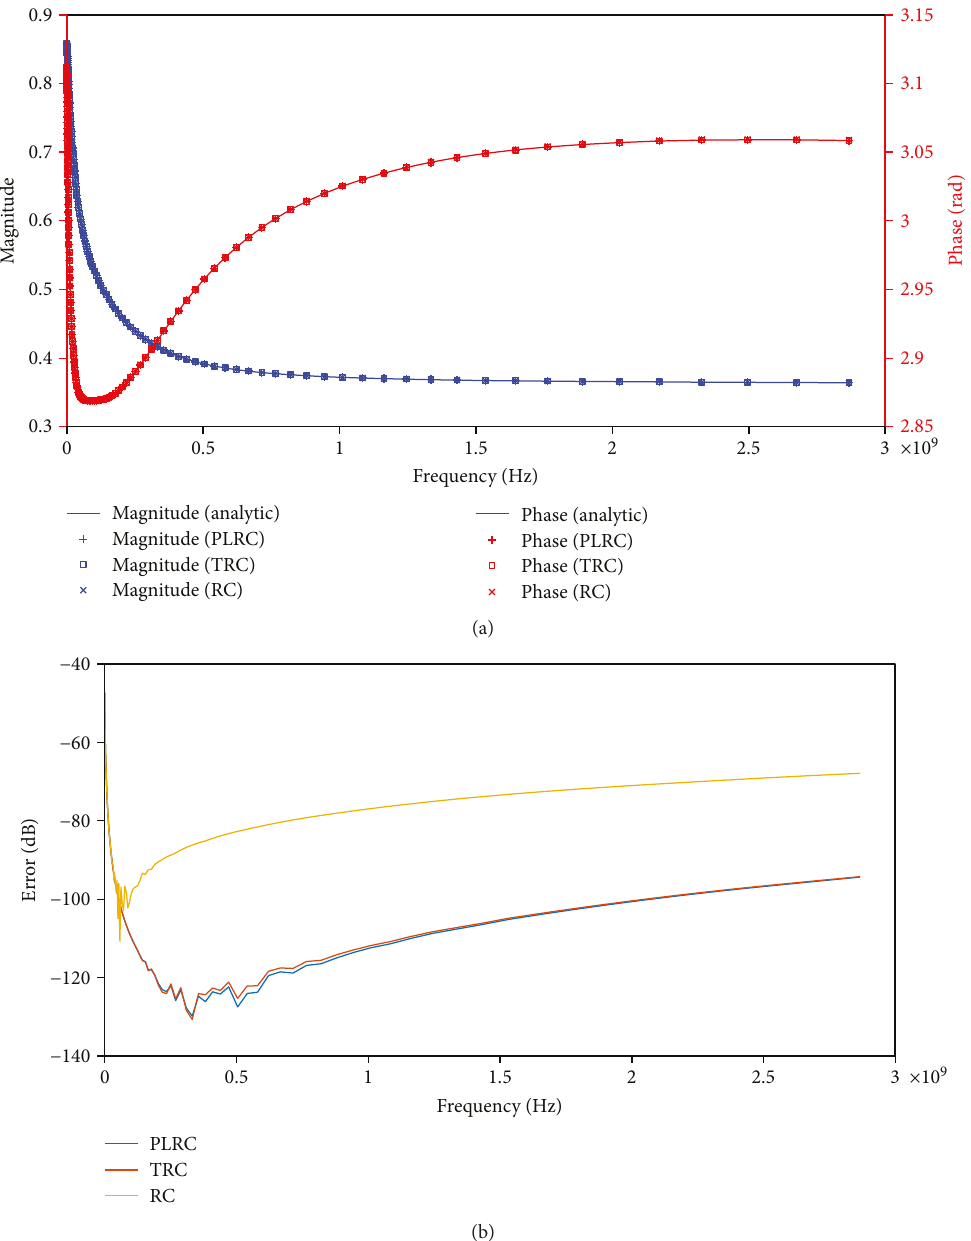
Figure 3: Comparison of the computed re fl ection coe ffi cient by RC, TRC, and PLRC techniques with the theoretical values. (a) Magnitude and phase. (b) Relative